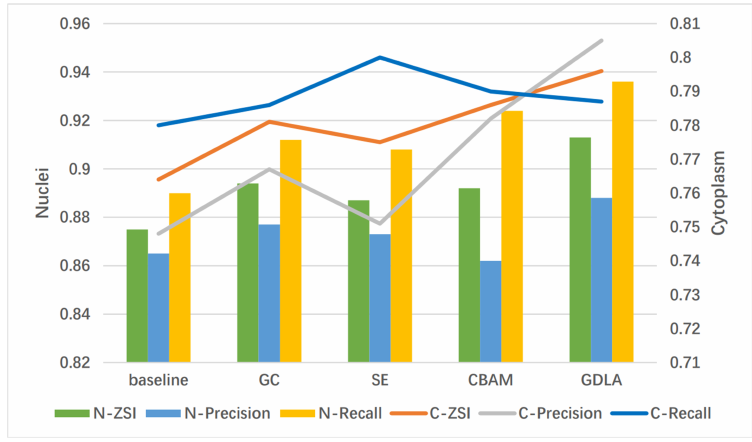
Figure 5. Visual results of the effect of different